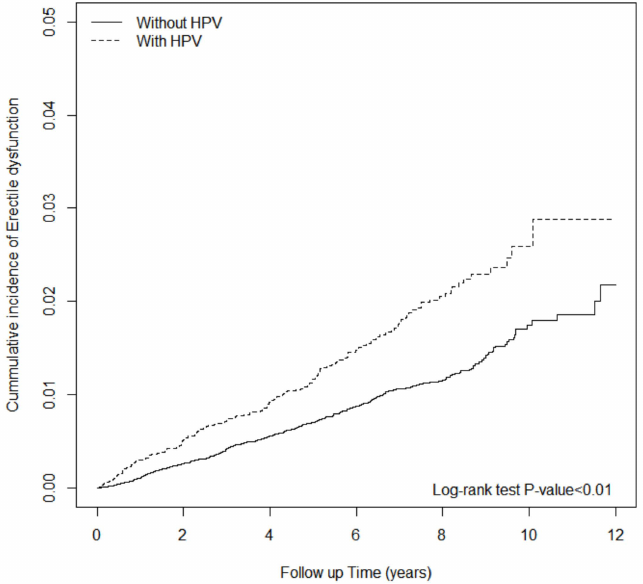
Figure 1. The cumulative incidence of erectile dysfunction in HPV-infected patients and non-HPV